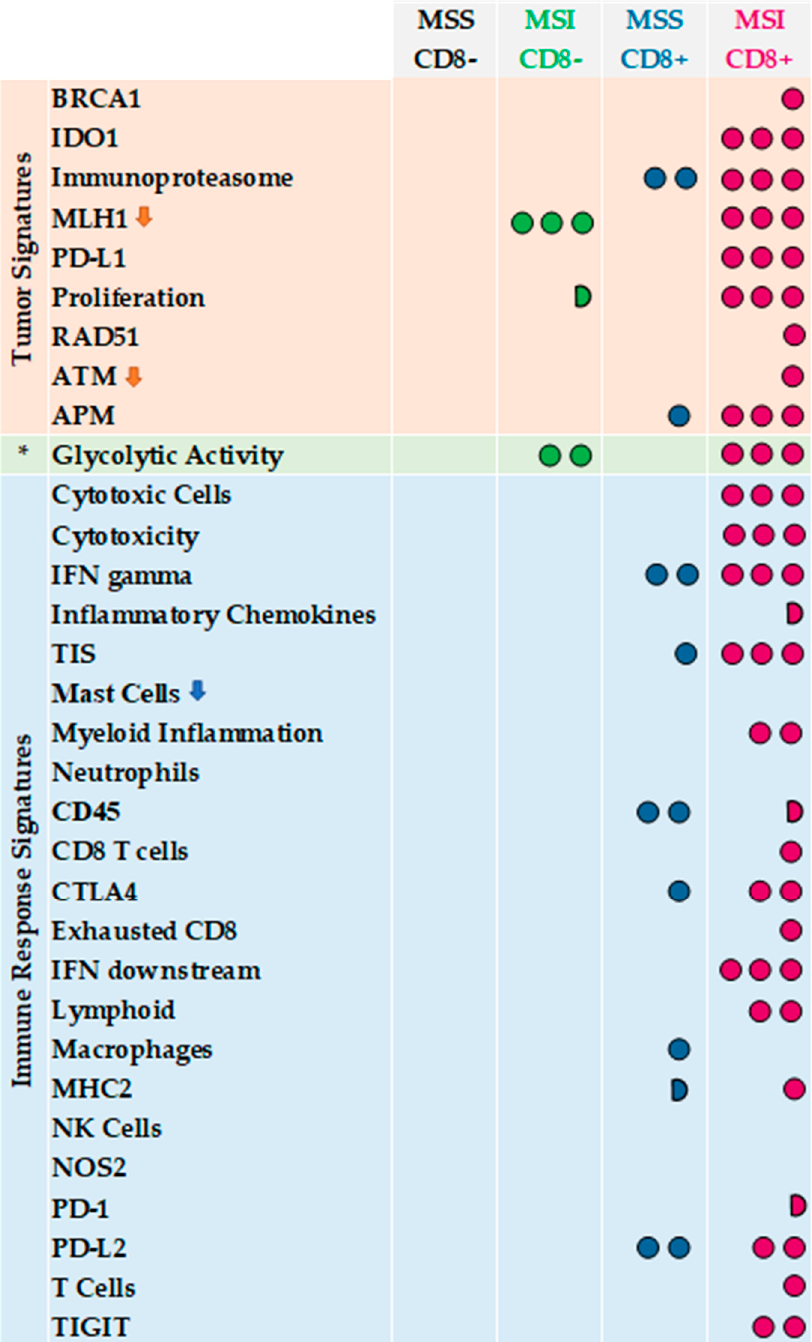
Figure 3. Tumor , tumor microeviroment (*) and immune response signatures that are significantly overexpressed/downregulated in MSI/CD8+ , MSS/CD8+ and MSI/CD8+ groups versus MSS/CD8 − (reference group). Three dots are for p < 0.0001, two dots are for p = 0.0001–0.01; one dot is for p = 0.02–0.05; half dot is for p = 0.06–0.07; the arrow indicates a downregulation of the signature.